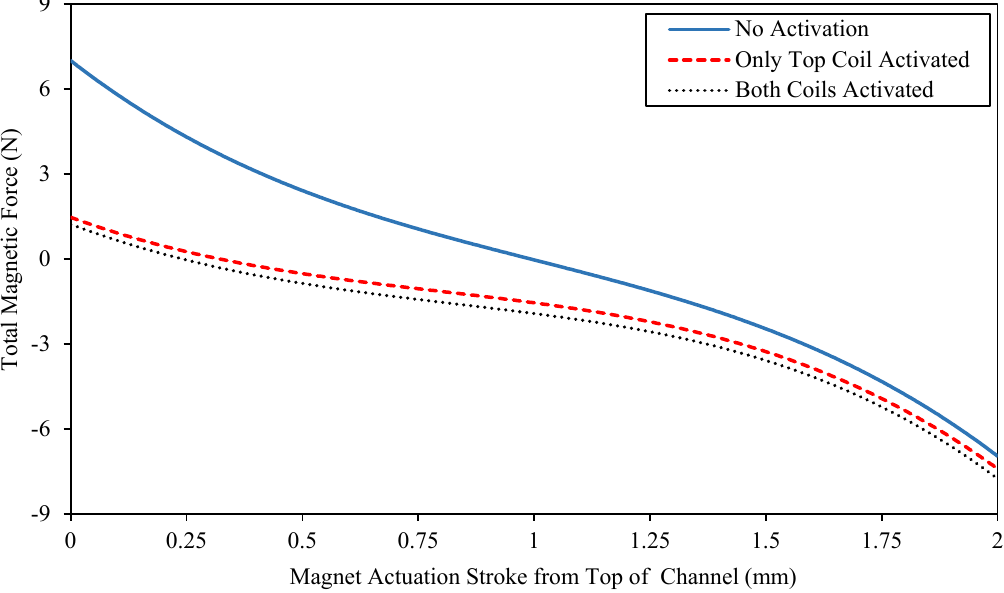
Figure 7. Total magnetic force on the permanent magnet along its stroke from the top to the lower end of the actuation channel for various coil-activation combination.